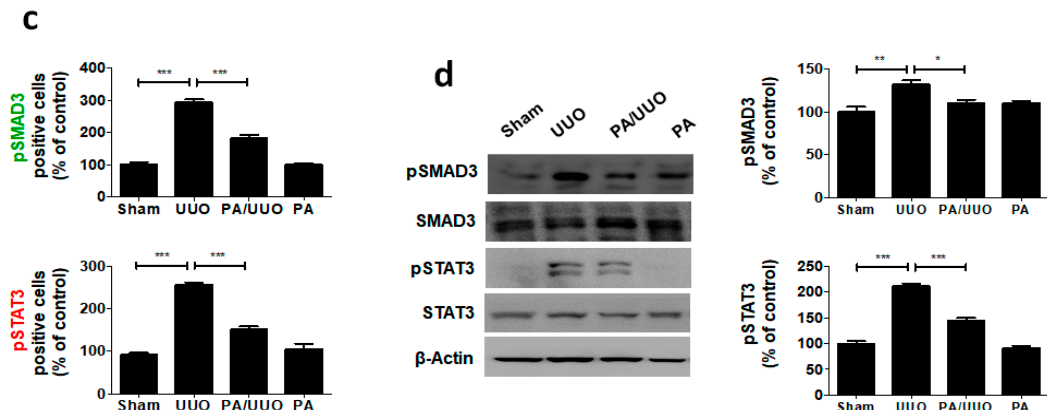
Figure 5. PA inhibits SMAD3-STAT3 signaling in vitro and in vivo. ( a ) Immunoblot shows the effects of PA on the inhibition of phosphorylated SMAD3-STAT3. ( b ) Immunofluorescence double staining for pSMAD3 (green) and pSTAT3 (red) localization. Cells were counterstained with Hoechst 33342 (blue). Scale bar 100 µ m. ( c ) Quantification of immunofluorescence double staining. ( d ) Immunoblot results the effects of PA on the SMAD3-STAT3 signaling in UUO mice. β -Actin was used to confirm equal sample loading. The data are representative of three independent experiments and quantified as mean values ± SEM. Tukey’s multiple comparison test, * p < 0.05, ** p < 0.01, *** p < 0.001 compared to control.